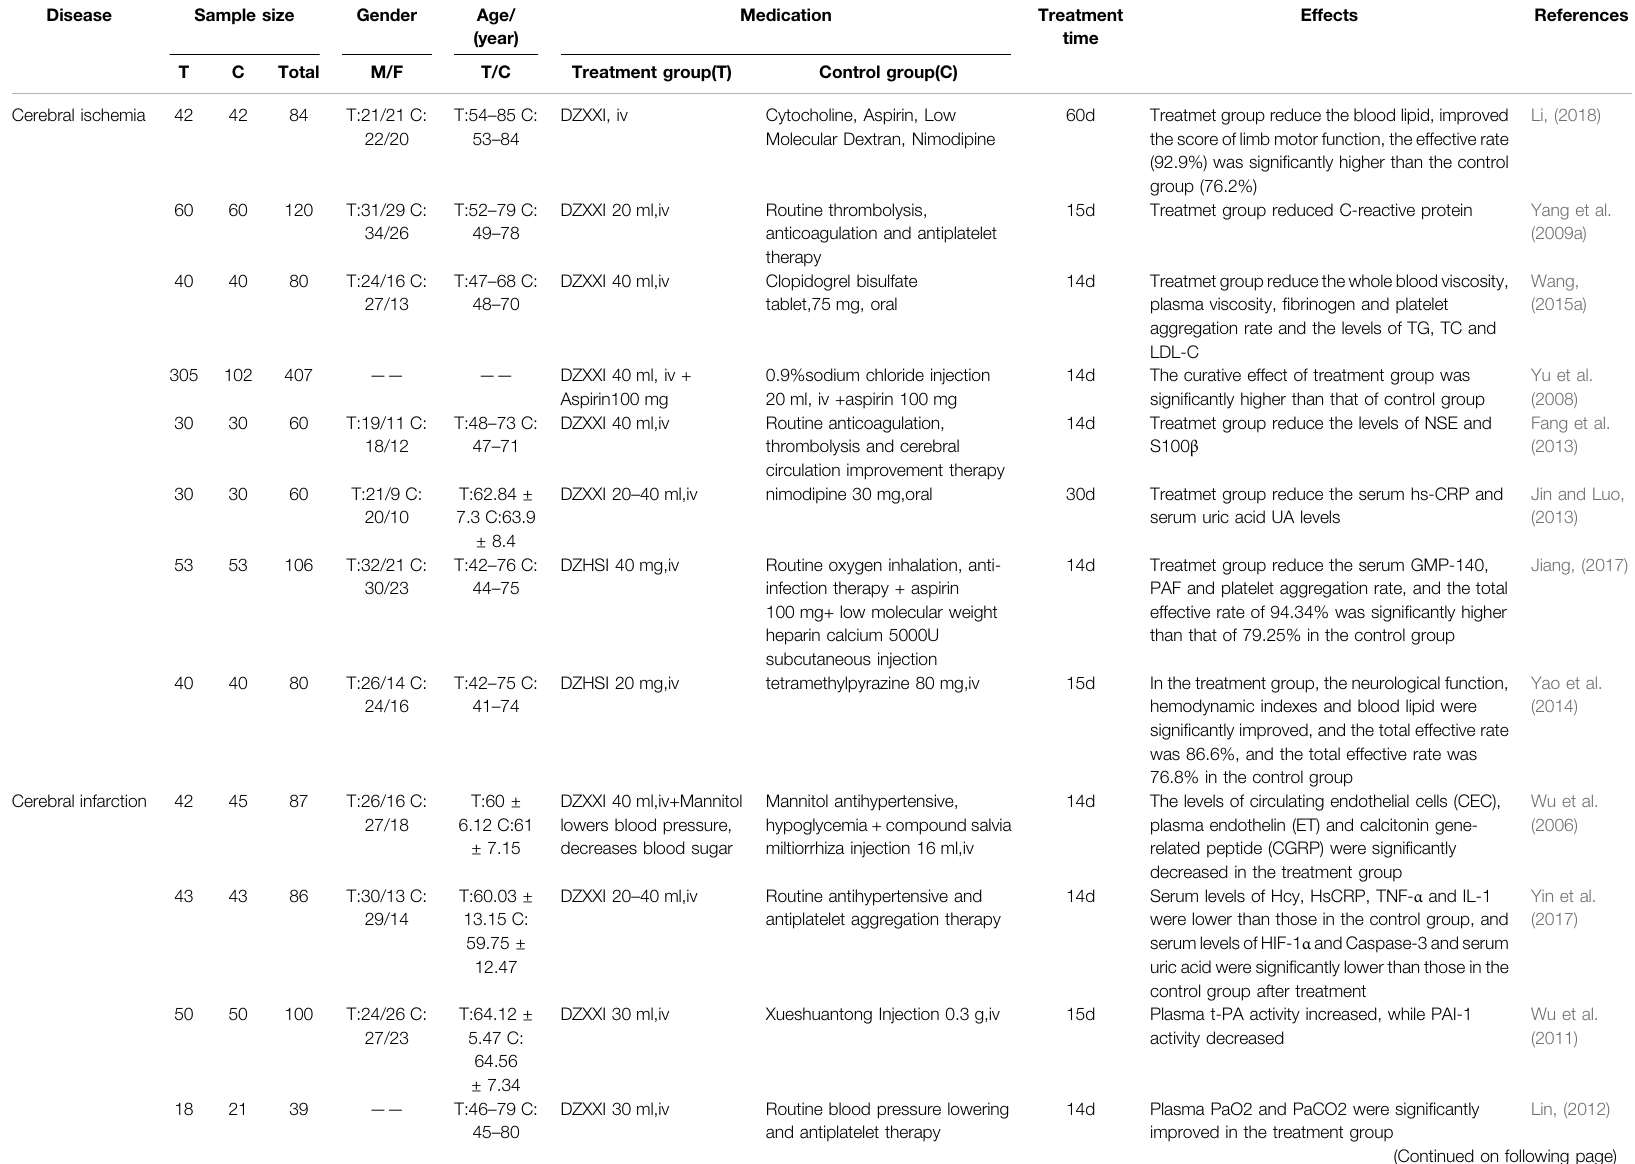
TABLE 3 | Clinical application of DZXX preparations in various diseases.